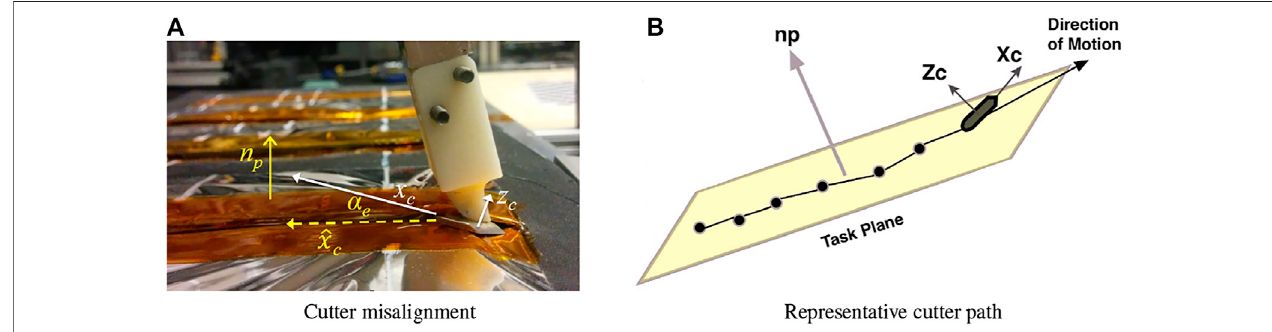
FIGURE7| Correctingtaskframemisalignment. (A) de fi nitionofterms:cutteraxis z c isnotperfectlyalignedwithplanenormal n p ,leadingtomisalignmentbetween commanded cutter direction x c and actual cutter direction ^ x c resulting from hybrid position/force control; (B) representative illustration of a cutter path on the plane.